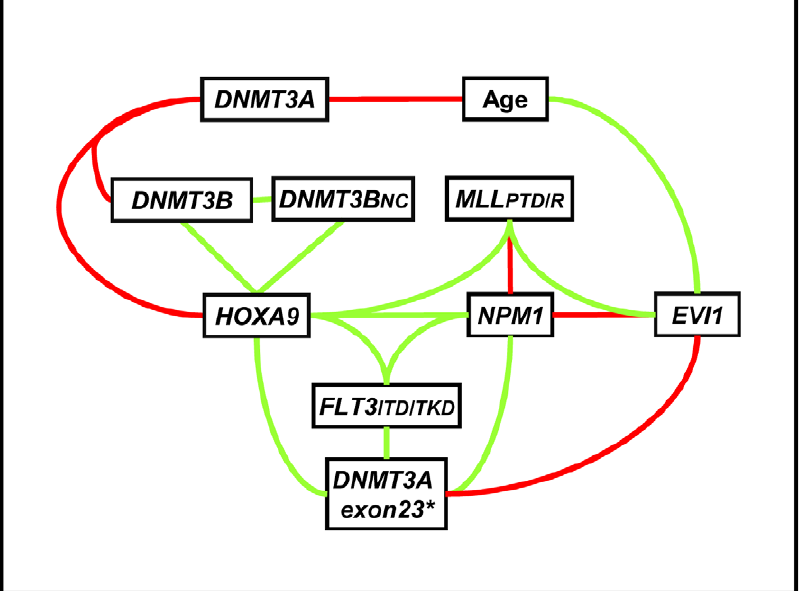
Figure 3. Statistically significant relationships between biomarkers. Graphical representation of significant Spearman’s rank correlation Mann-Whitney U-test and/or Fisher’s exact test between two quantitative, quantitative/binary and binary variables;. Green lines significant positive relationships between the two variables tested; red lines: inversely related. Significant p values ( , 0.05). DNMT3A exon 23*: mutations in exon 23 of DNMT3A.